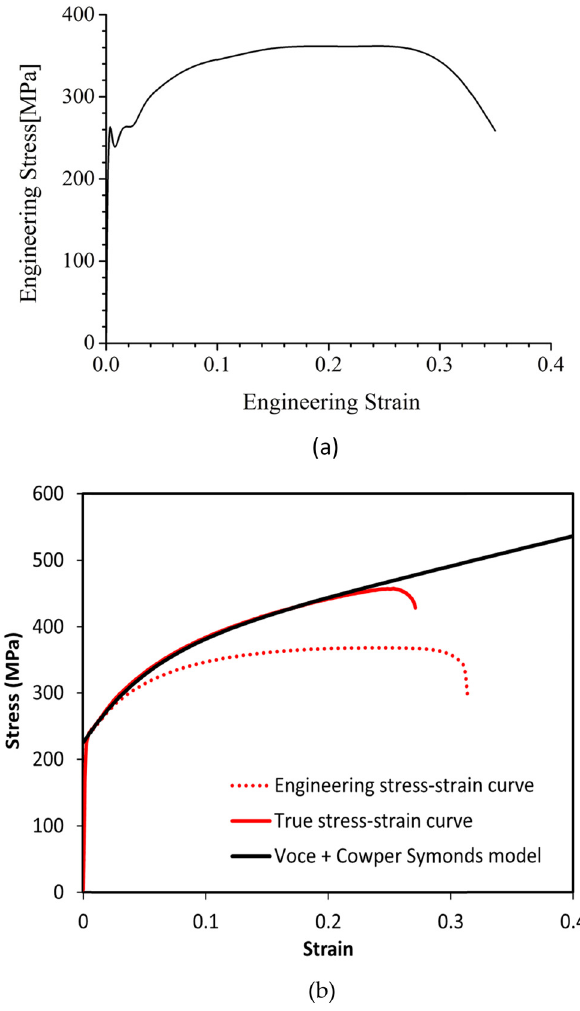
Figure 10: The engineering stress versus engineering strain. ( a ) Mild steel [ 31 ] and ( b ) SAE 1008 carbon steel [ 20 ]